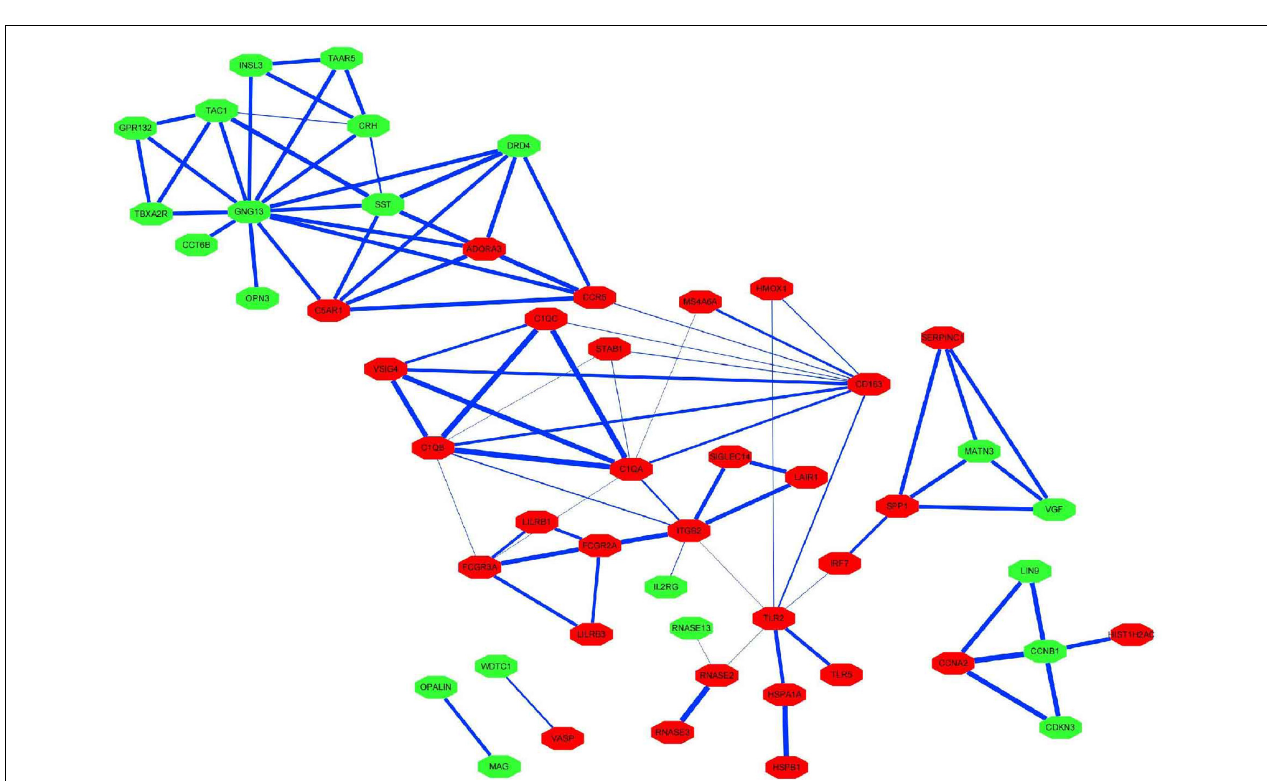
FIGURE 4 | Protein–protein interaction network for the proteins encoded by the overlapping differentially expressed genes. The nodes represent the encoded proteins and the edges represent their interactions. Green indicates downregulated genes; red indicates upregulated genes. The width of the blue line indicates the combined score obtained using the STRING